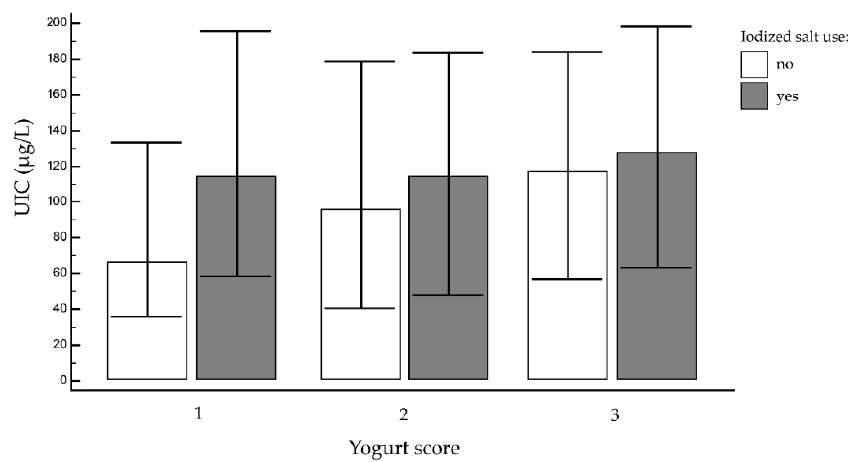
Figure 4. Median urinary iodine concentration (UIC) and yogurt score (1 = never; 2 = at least once a week; or 3 = more than once a week) in iodized salt users (grey bars) and non-users (white bars). Bars represent UIC median values, ( µ g / L), while error bars represent interquartile range interval of the median value.